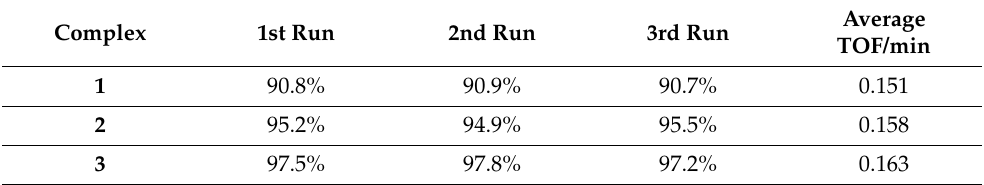
Table 6. Reproducibility of catalysts in the reduction of 4-NP (1.0 mol% catalyst, % after 60 min).